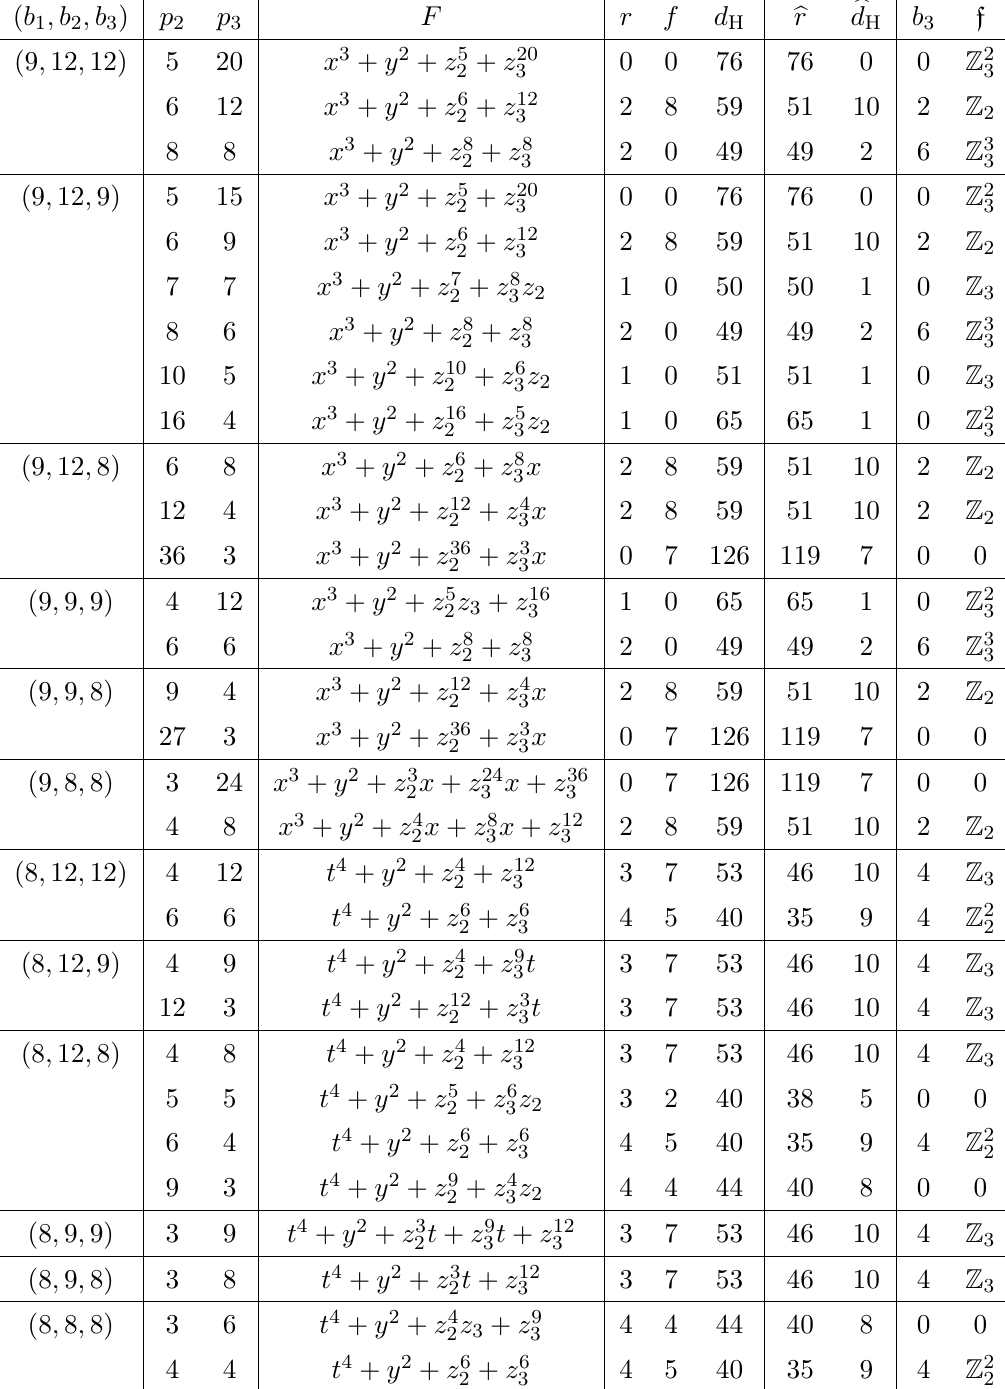
Table 21 . Models for G = E 6 with b 1 = 8 , 9